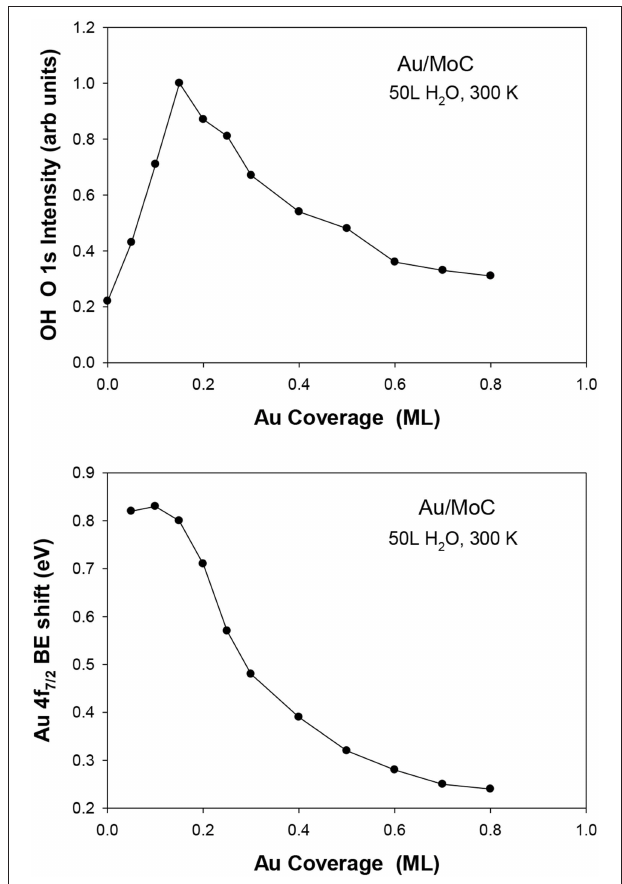
FIGURE 8 | Results of XPS collected after dosing 50 langmuir (L) of water at 300K to δ -MoC and Au/ δ -MoC surfaces. Top: Amount of OH seen in the O 1s region. Bottom: Corresponding binding shift in the Au 4f 7 / 2 binding energy. Reproduced with permission from Posada-Perez et al. (2017), copyright 2017 by Royal Society of Chemistry.